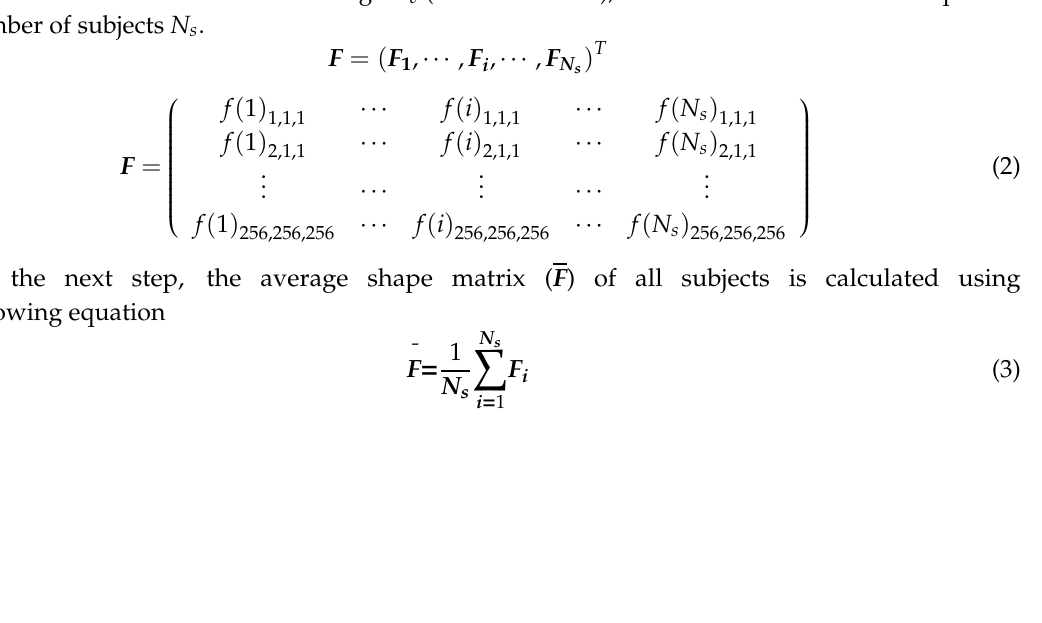
Figure 5. The 3-D coordinate system for the humeral head (A: anterior, P: posterior).